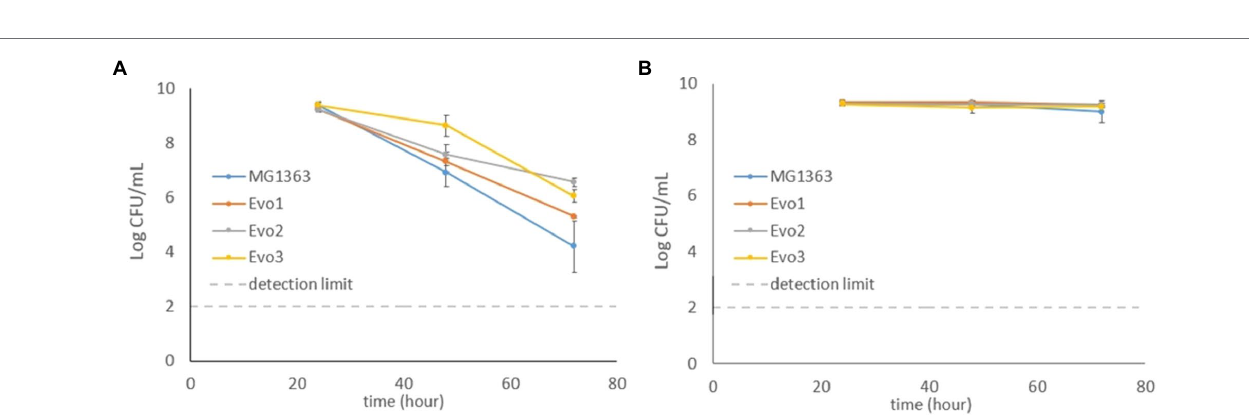
FIGURE 3 | Viable plate counts of MG1363 and evolved strains throughout 72h under (A) static fermentation and (B) respiration-permissive conditions in GM17media at 30°C. Data from biological triplicates, error bars represent